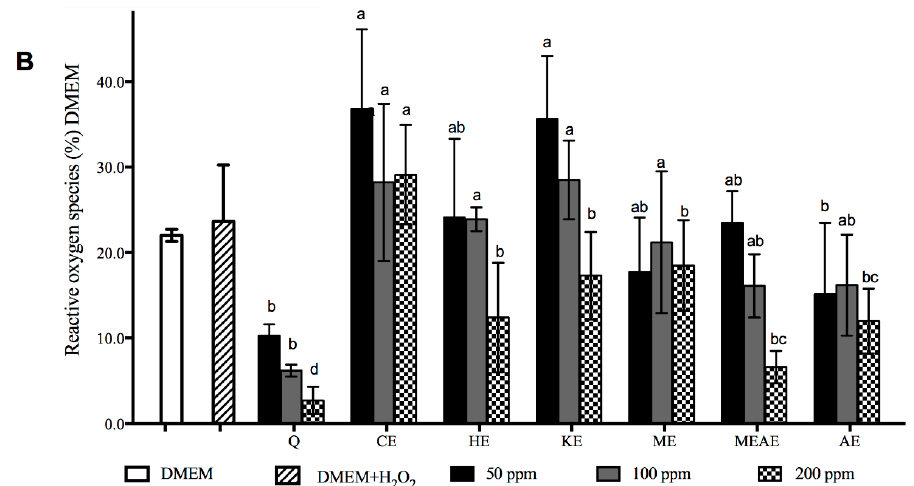
Figure 3. Representative images of reactive oxygen species (ROS) produced on porcine kidney cells exposed to H 2 O 2 and to 200 ppm of extracts of Acacia farnesiana pods ( A ) and ROS quantification using 50, 100 and 200 ppm of extracts ( B ). H 2 O 2 = hydrogen peroxide; Q = quercetin; CE = chloroformic extract; HE = hexanic extract; KE = ketonic extract; ME = methanolic